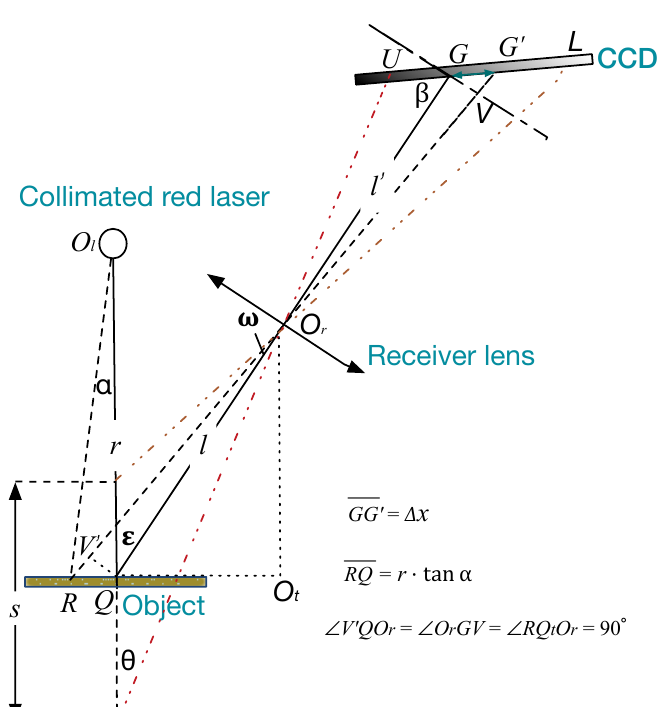
Figure 1. Structure of the optical path when the laser beam is dithered by an angle α